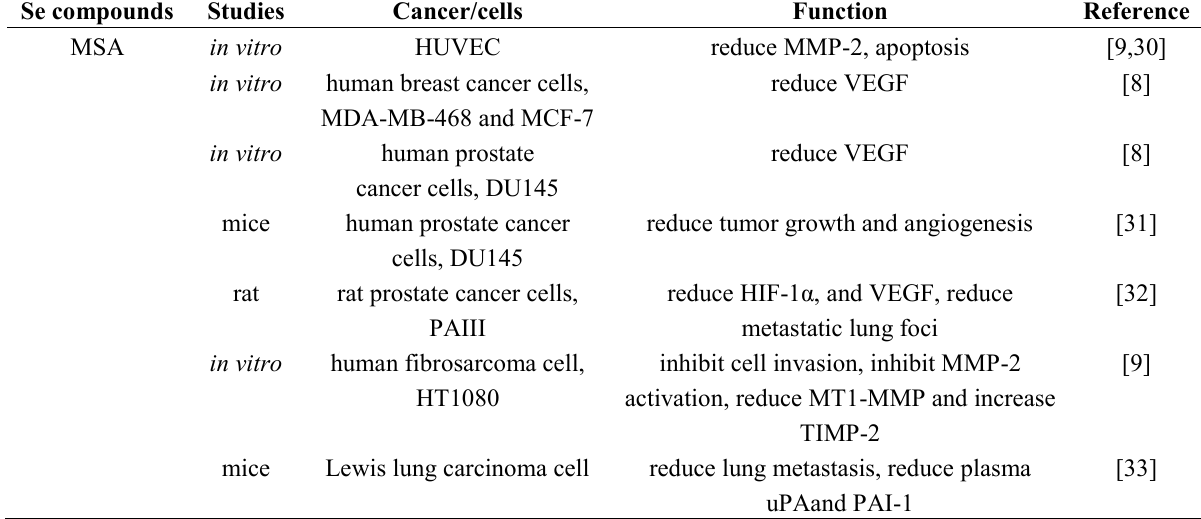
Table 1. Effects of Se compounds on metastasis (migration, invasion, and angiogenesis). Se